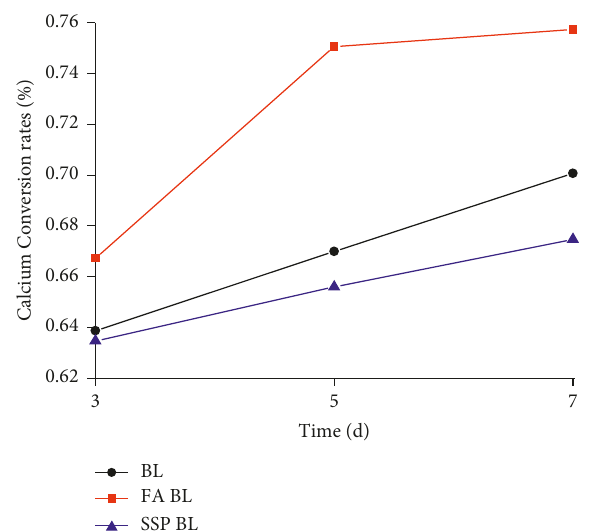
Figure 12: Efficiency of Ca 2+ curing by different Sporosarcina pasteurii .